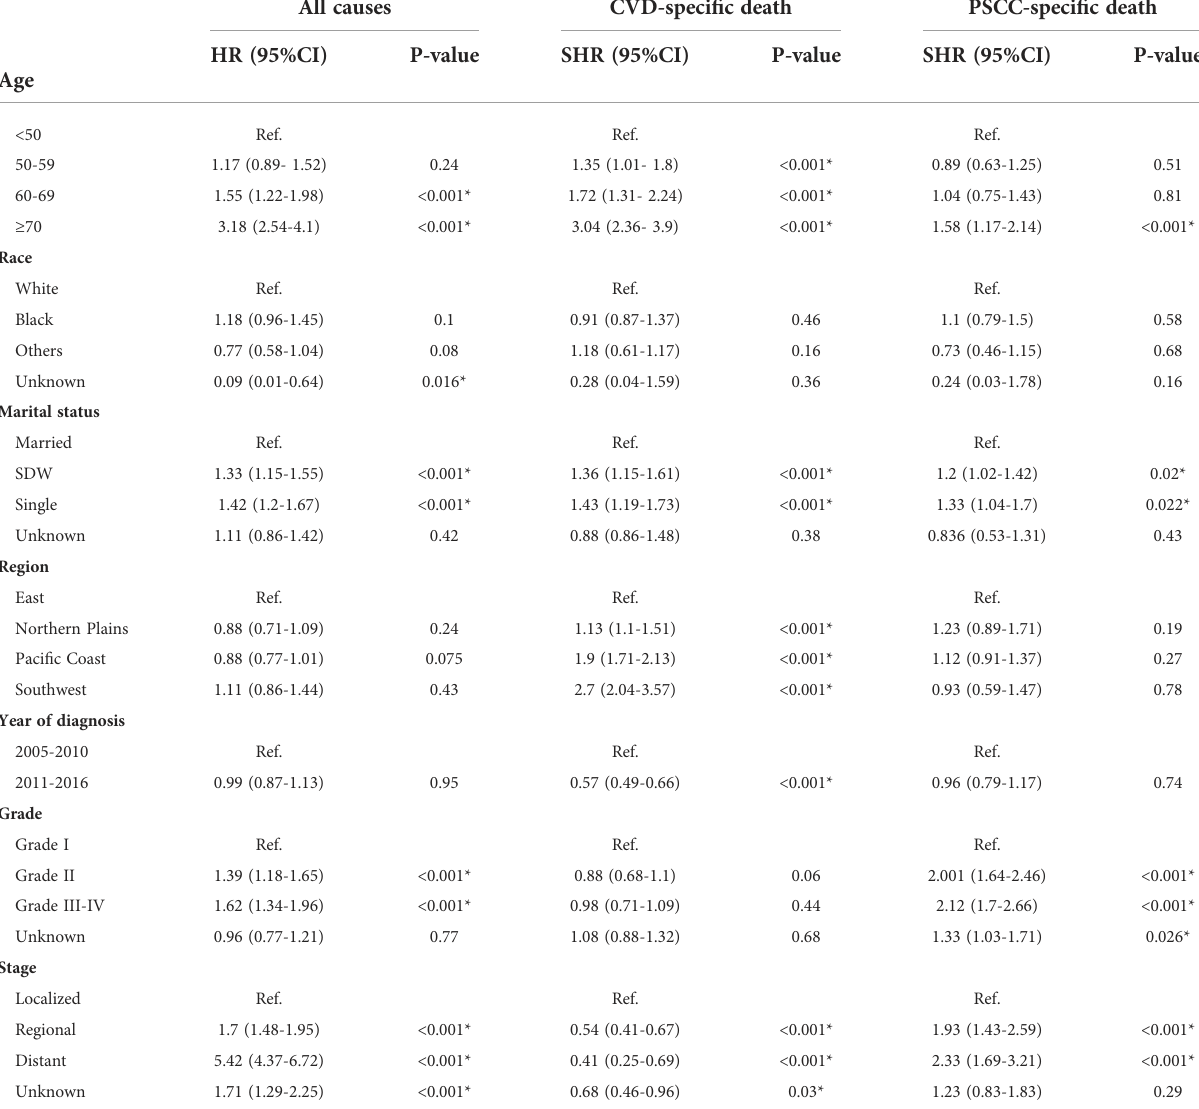
TABLE 3 All-cause, CVD-related, and PSCC-related mortality of patients by demographic and clinical characteristics at diagnosis. All